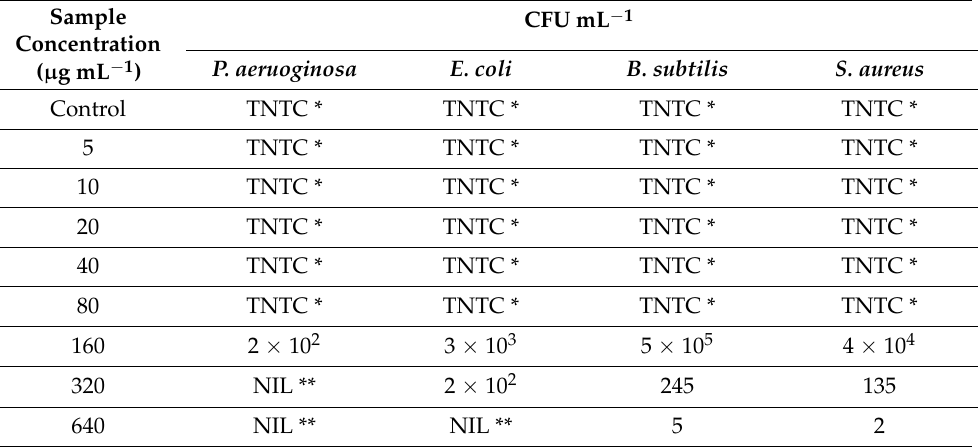
Table 2. Least bactericidal potential of ZnONPs synthesized using oat biomass on P. aeruginosa , E. coli , B. subtilis and S. aureus .